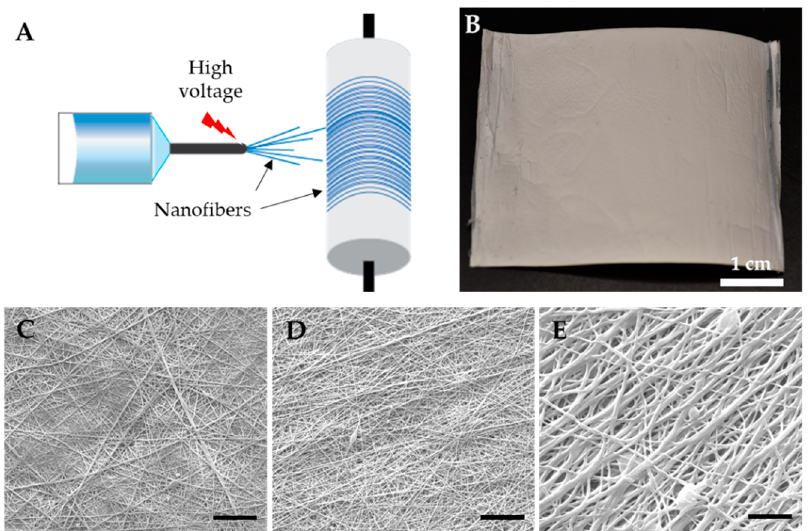
Figure 1. Fabrication of NO-fibers. ( A ) Schematic of electrospinning of NO-fibers. The polymer solution is emitted through the needle when high voltage is applied to the tip of the needle and fibers are collected on a rotating collector; ( B ) photograph of an electrospun sheet of PVP NO-fibers. Scanning electron microscope images of PVP NO-fibers: ( C ) PROLI–NO-fibers; ( D ) DPTA–NO-fibers; ( E ) DETA–NO-fibers. Scale bar: 5 µm.